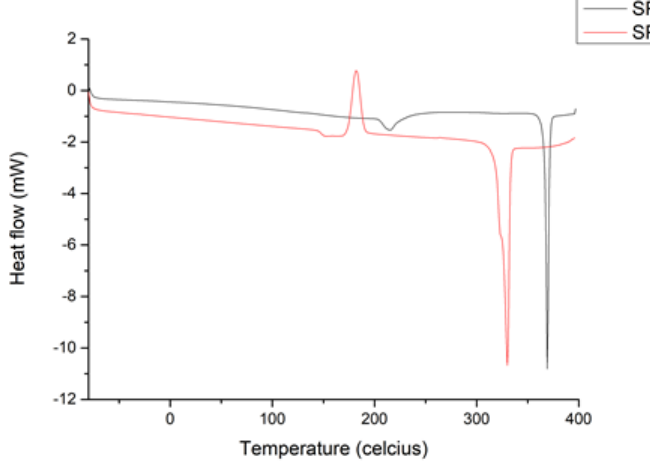
Figure 1. Differential scanning calorimetry (DSC) curves of diphenylacridine (SP1) and phenothiazine (SP2).